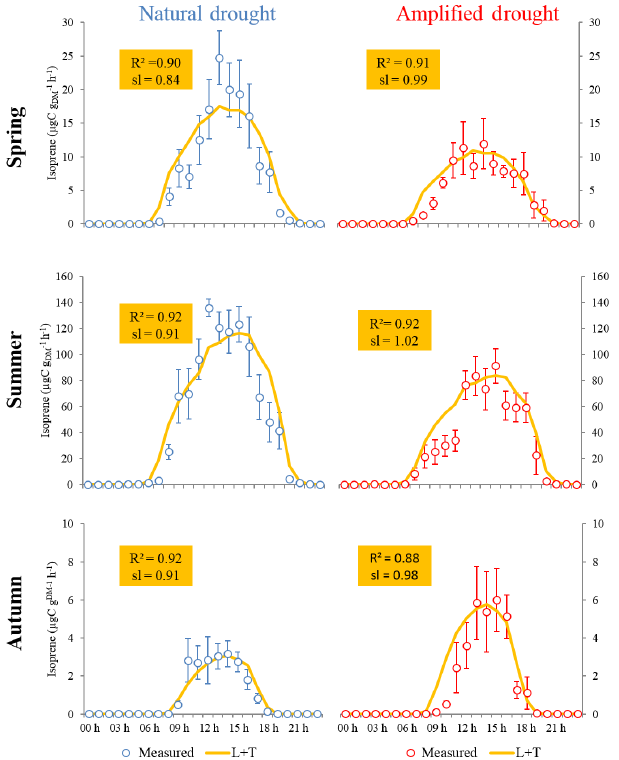
Figure 3. Diurnal pattern of isoprene emission rates, where points represent measured emission and the yellow line corresponds to modeled emission rates according to the L + T algorithm (ER L + T ) . R 2 and slope (sl) of correlations between measured ( x axis) and modeled ( y axis) emissions are presented in the yellow frame. Cor- relations were obtained without forcing data to pass through the origin. Values are mean ± SE, n = 5.